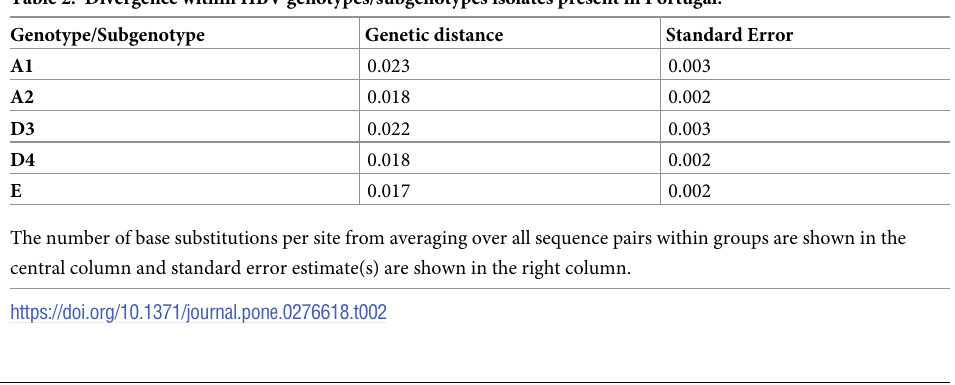
The number of base substitutions per site from averaging over all sequence pairs between groups are shown above the diagonal and standard error estimate(s) are shown below the diagonal in bold.